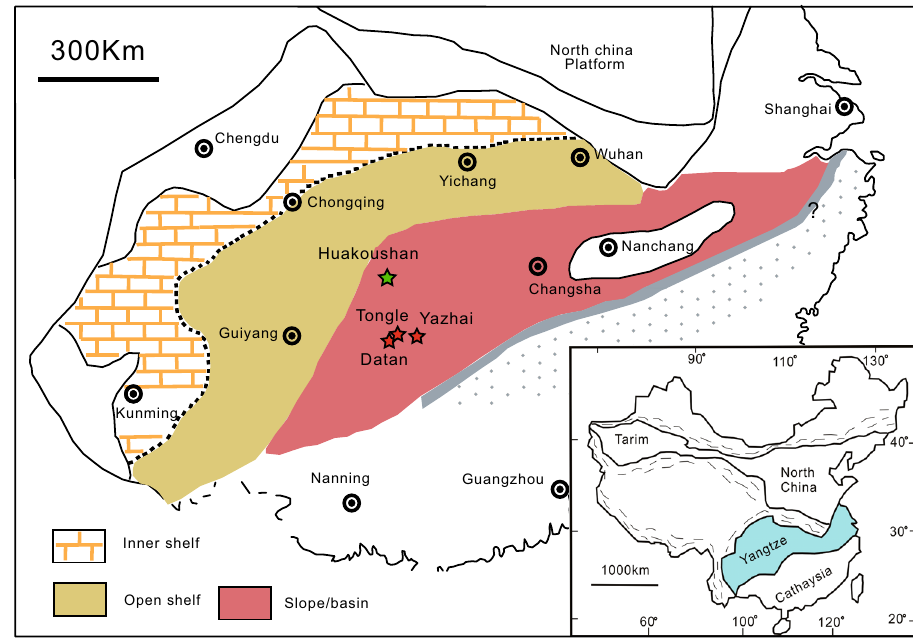
Fig. 1 The paleogeographic map of South China Block in late Neoproterozoic Era 7 . The green star marks the location of Huakoushan section (slope environment). The red stars mark the locations of Yazhai, Tongle, and Datan sections (basin